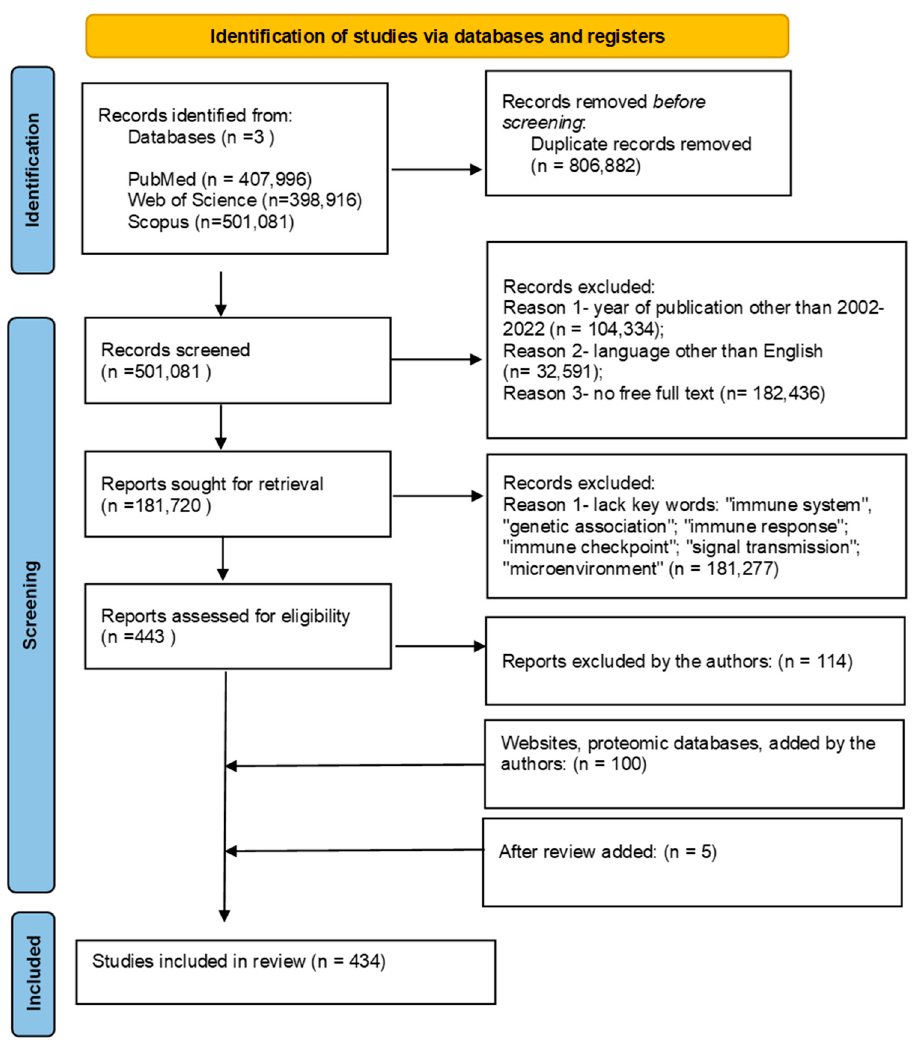
Figure 6. Strategy for searching articles for literature review based on PRISMA flow diagram (based on https://www.prisma-statement.org/PRISMAStatement, accessed on 22 November 2022).